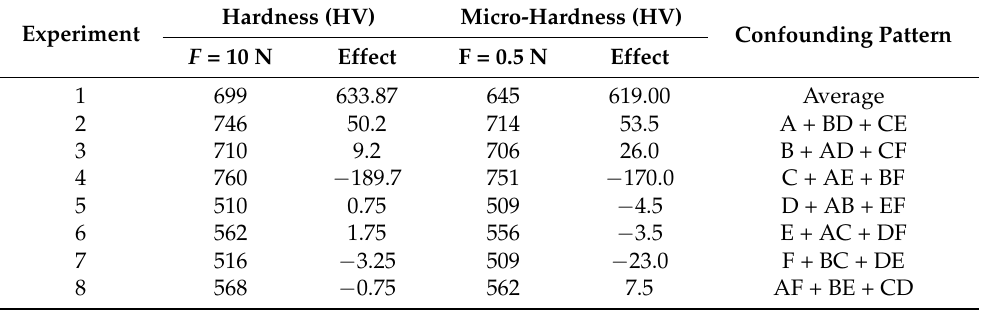
Table 8. Average hardness measures to an interior distance of 2 mm from the end of the nitride